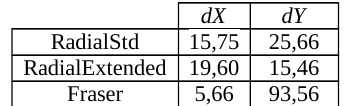
Table 4: Difference (in pixels) between the principal point and the center of distortion